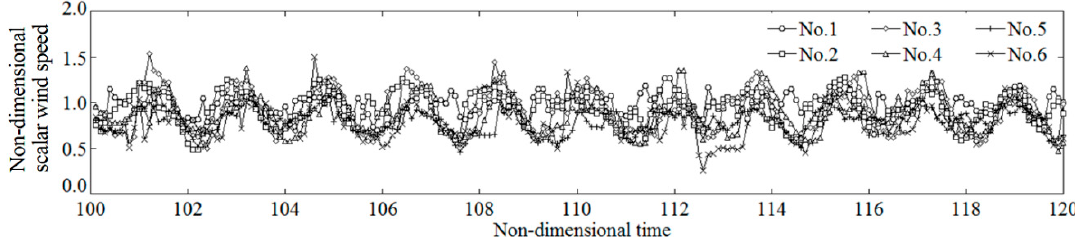
Figure 6. Temporal changes of scalar wind speed at the hub height (50.0 m). Duration of time shown on the horizontal axis is approximately 45.0 min (for U in = 5.0 m/s).